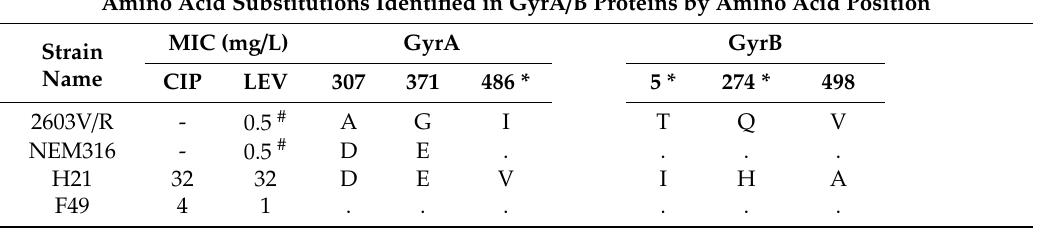
Table 4. Amino acid substitutions of quinolone-resistant determinants gyrA / B and parC / E. Amino Acid Substitutions Identified in GyrA / B Proteins by Amino Acid